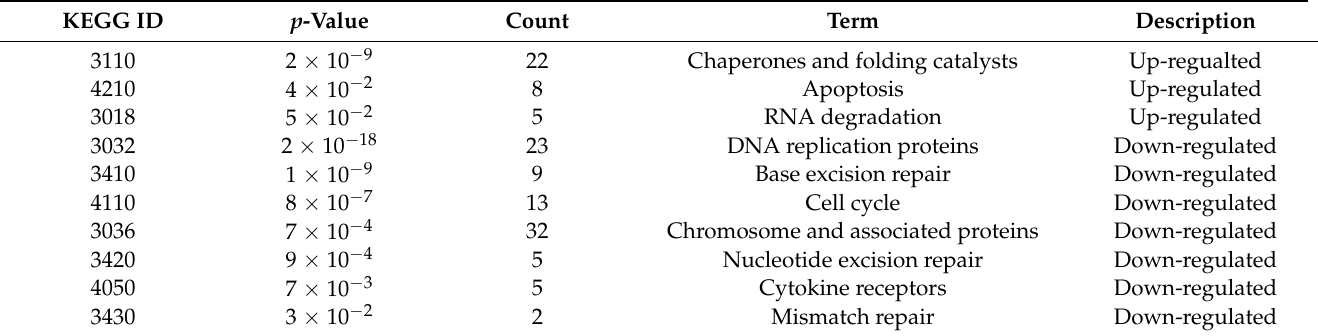
Table 5. KEGG enrichment results after the abrupt temperature rise